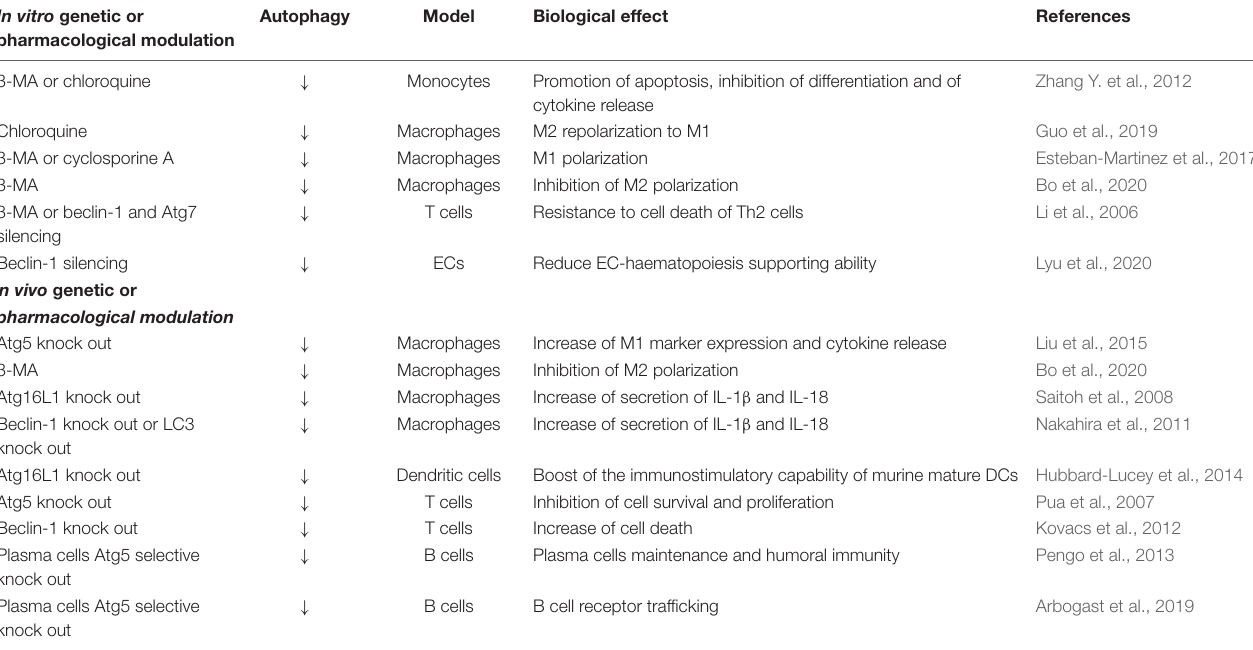
TABLE 3 | A summary of the current knowledge on the role of autophagy in the maintenance of immune cells behavior and